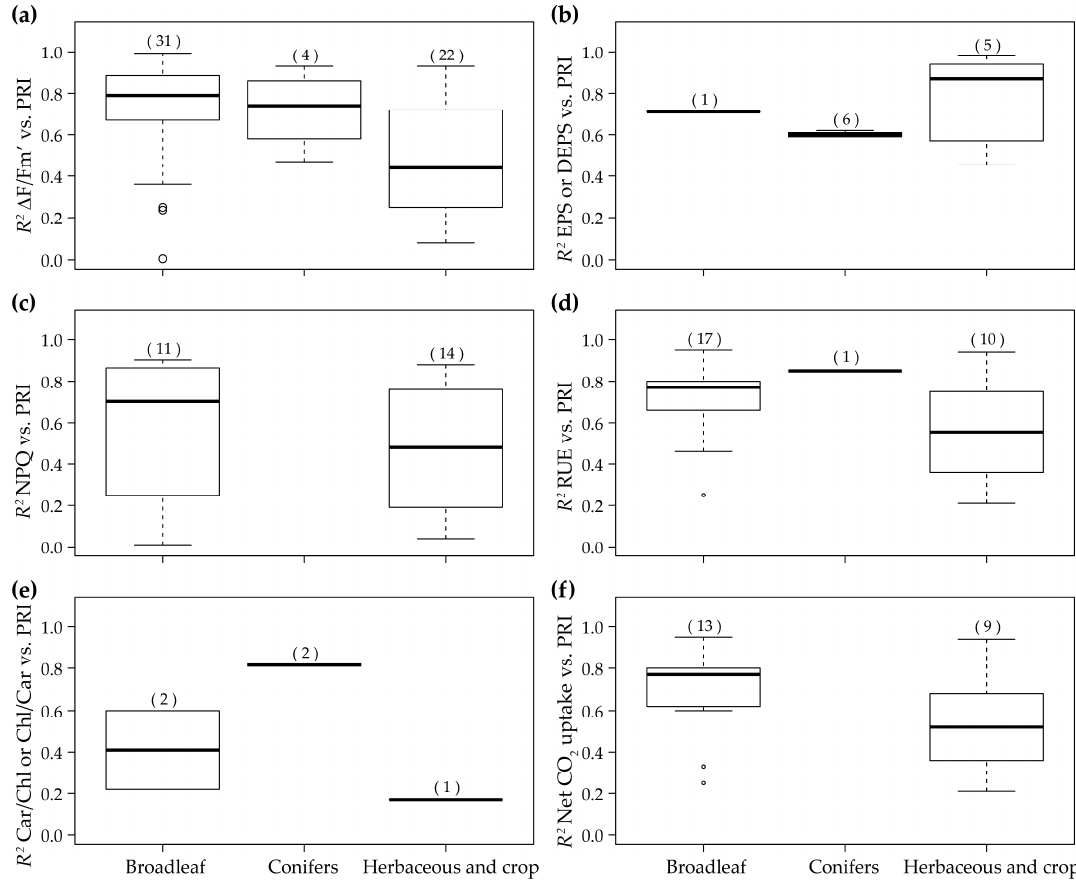
Figure 1. Boxplots of the coefficients of determination of the relationships between PRI and physiological variables at the foliar level and diurnal timescale: ( a ) Actual photochemical efficiency ( ∆ F/Fm’); ( b ) Epoxidation or de-epoxidation state of xanthophylls (EPS or DEPS); ( c ) Non-photochemical quenching (NPQ); ( d ) Radiation-use efficiency (RUE); ( e ) Carotenoid/chlorophyll (Car/Chl) or chlorophyll/carotenoid (Chl/Car) ratio; and ( f ) Net CO 2 uptake. Central lines represent medians, boxes represent 50% of the data, whiskers represent minima and maxima and circles represent outliers. The numbers of correlations reported in the literature are shown in brackets.